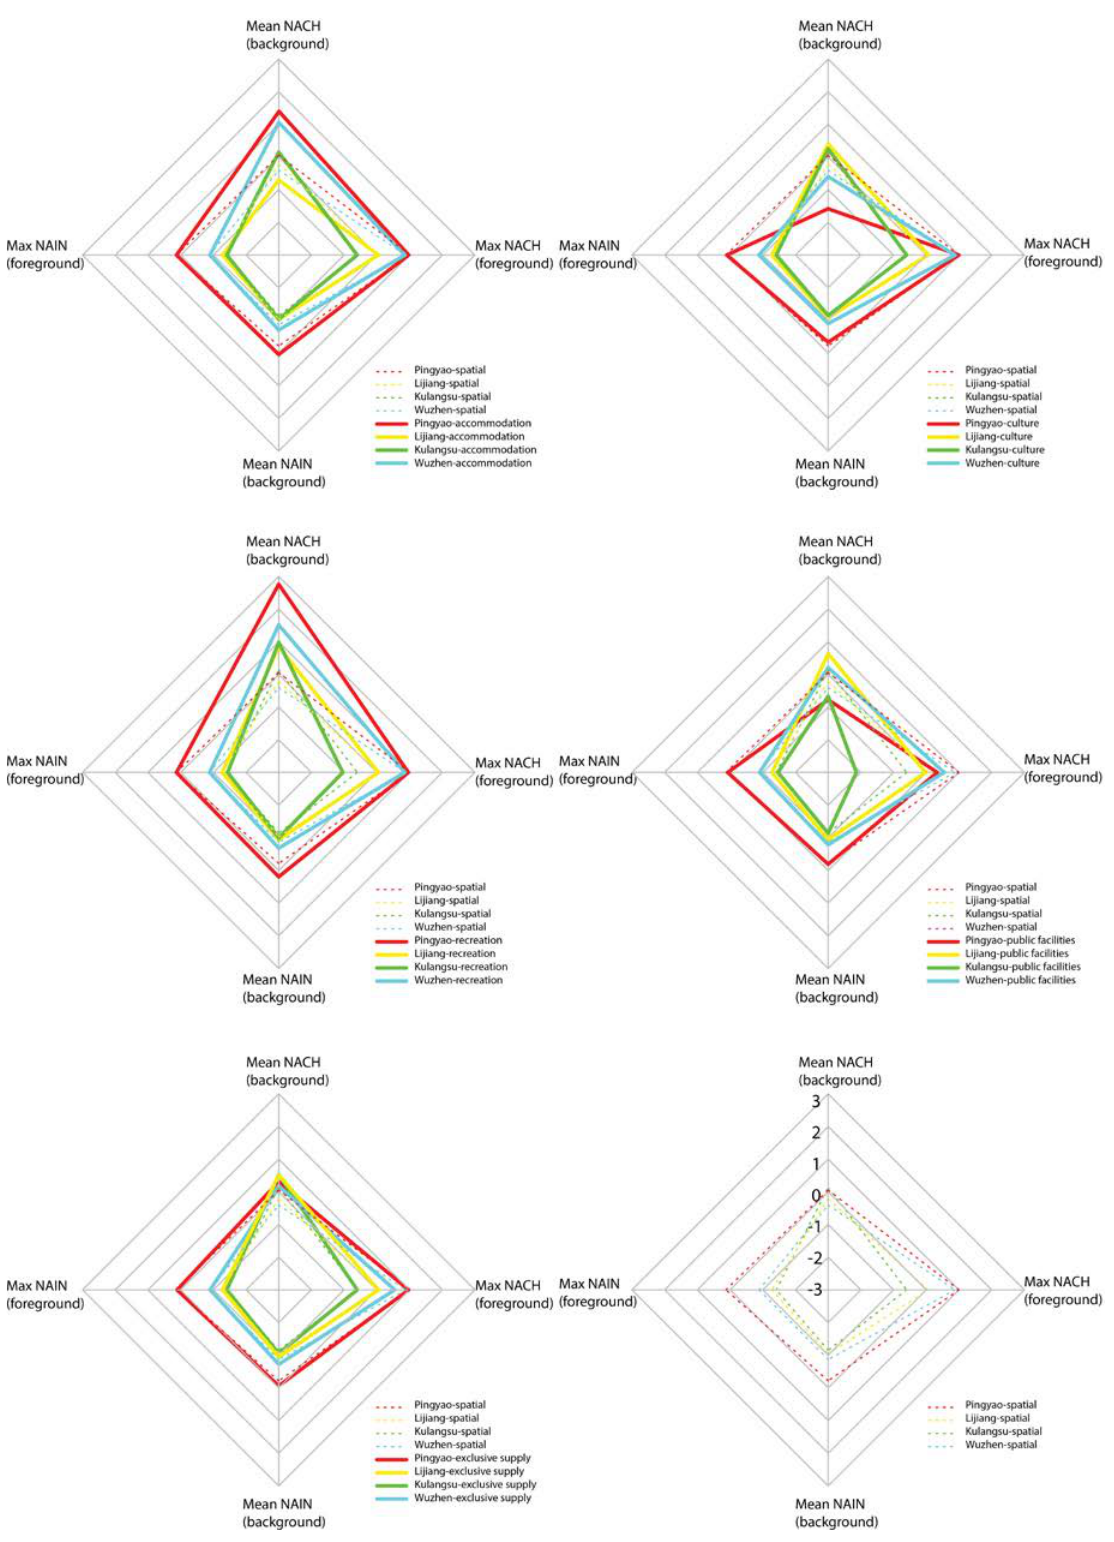
Figure 10. The star model of each type of POI land use, benchmarking against the SSMs of the entire street network at the global scale.